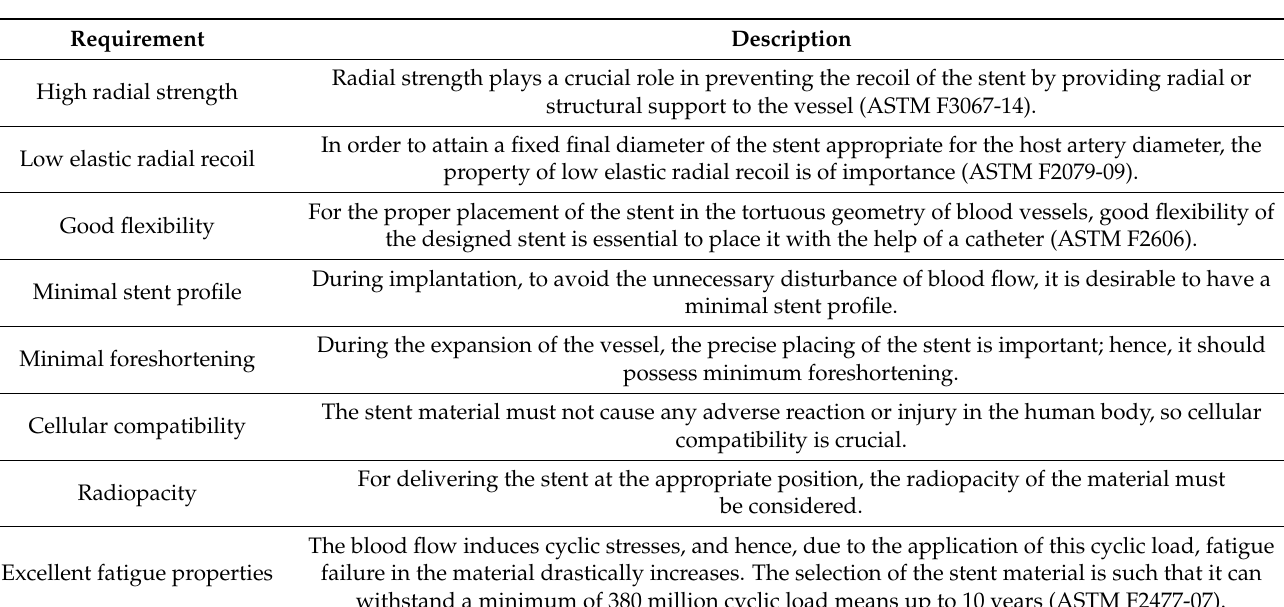
Table 1. Requirements and properties that devices (stents) and materials must satisfy to avoid failure (adapted from